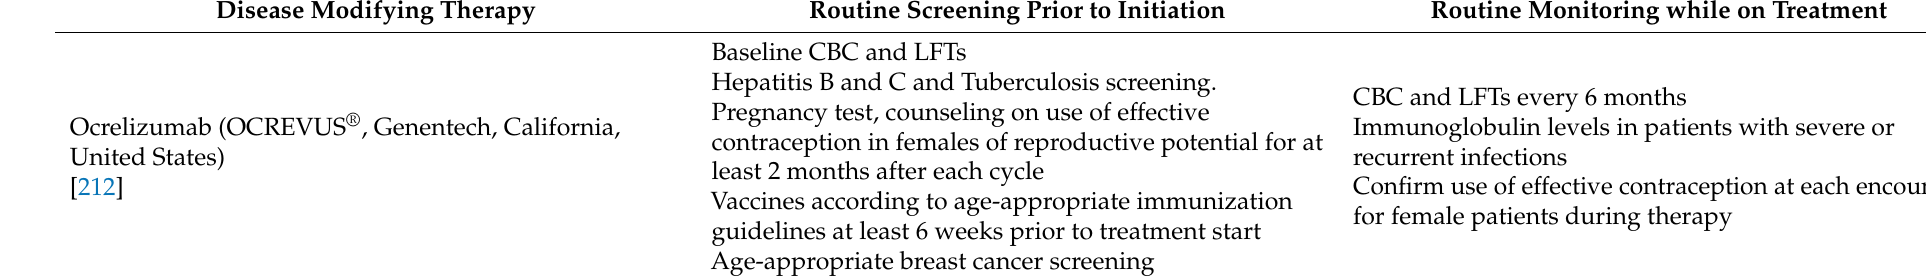
Table 2. Cont. Disease Modifying